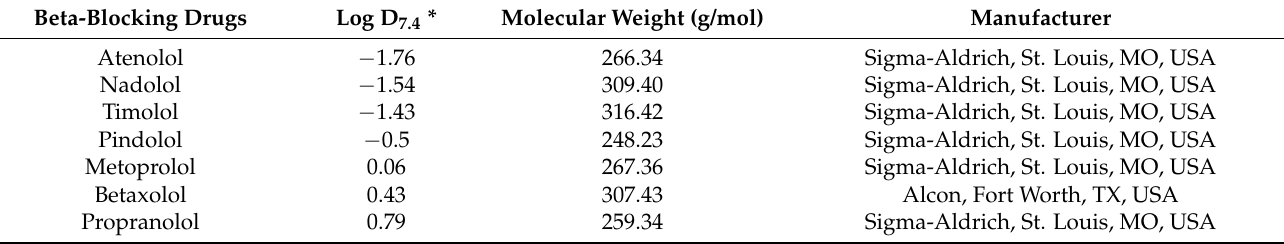
Table 1. Beta-blocking drugs in the